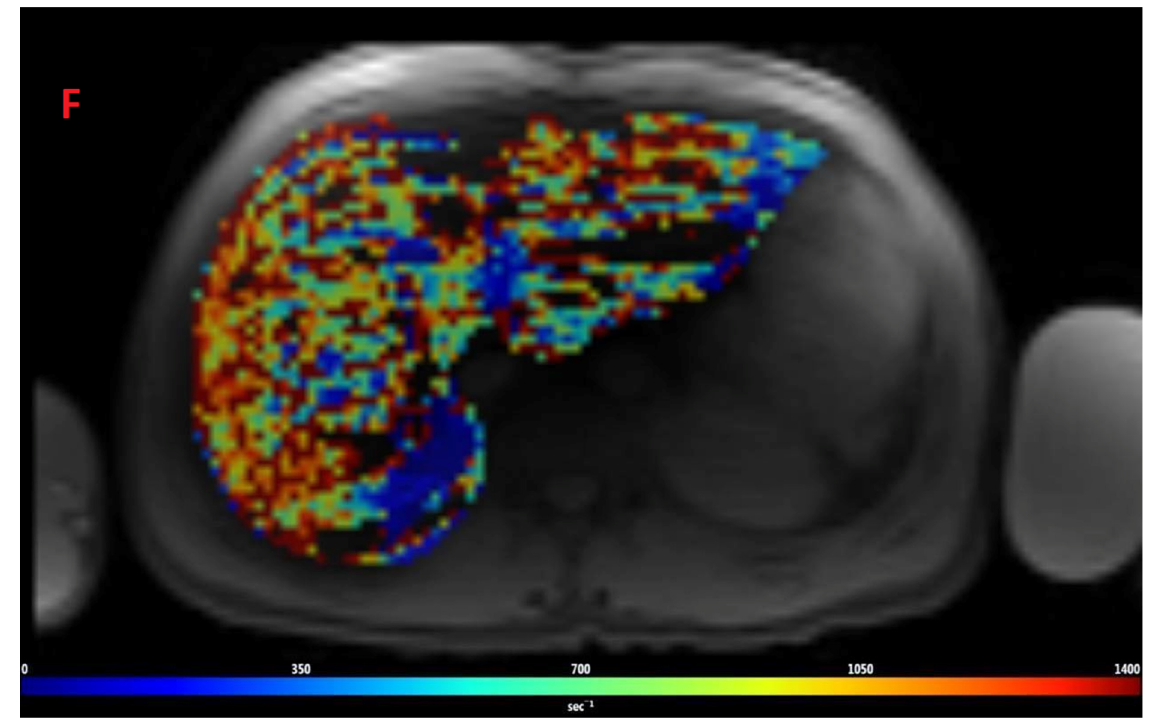
Figure 2. Representative images showing ( A ) the gradient axial echo slices; ( B ) post-processed liver iron concentration (LIC) map (color scale shows the range of LIC from 0 to 45 mg/g); and ( C ) R2* map in a patient with beta thalassemia assessed for iron overload at time point 1, which provided an estimated LIC of 26.6 mg/g. The lower panel ( D – F ) demonstrates gradient axial echo slice, post- processed LIC map, and R2* map, respectively, acquired from a scan performed after two years. The estimated LIC was 31.1 mg/g at time point 2.